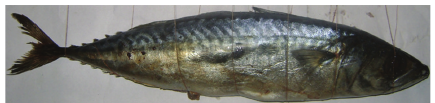
Figure 2: A lateral view of a Mackerel. This sample (394.01 mm long) was translated into CAD model and the robot construction was based on